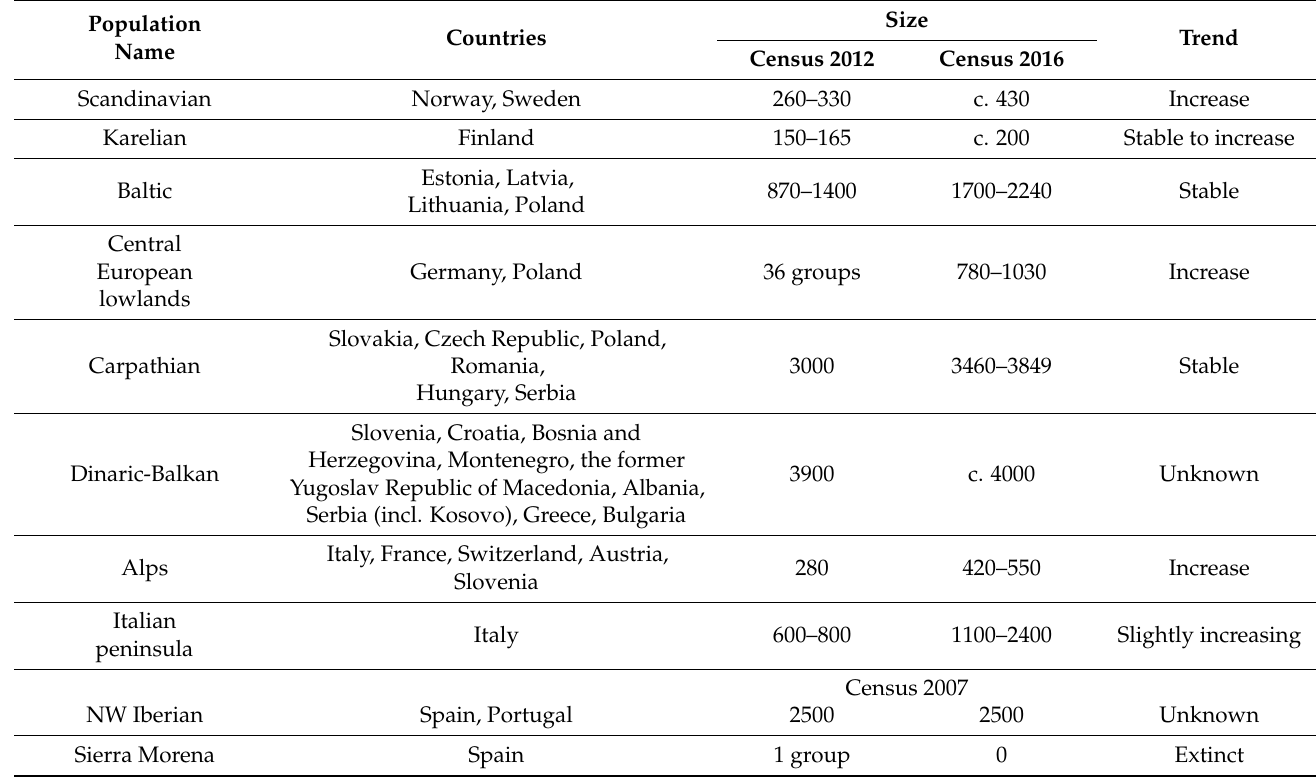
Table 1. Distribution and presence of the wolf in Europe and in the EU member